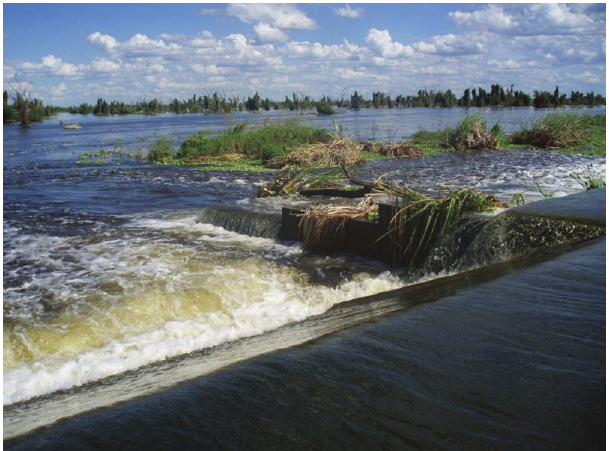
Fig. 6 . View of a fish ladder (pool and weir system) operating during high flow conditions showing the contrast between discharge from spillway and attraction flow derived from the fish ladder. Note the debris inside the